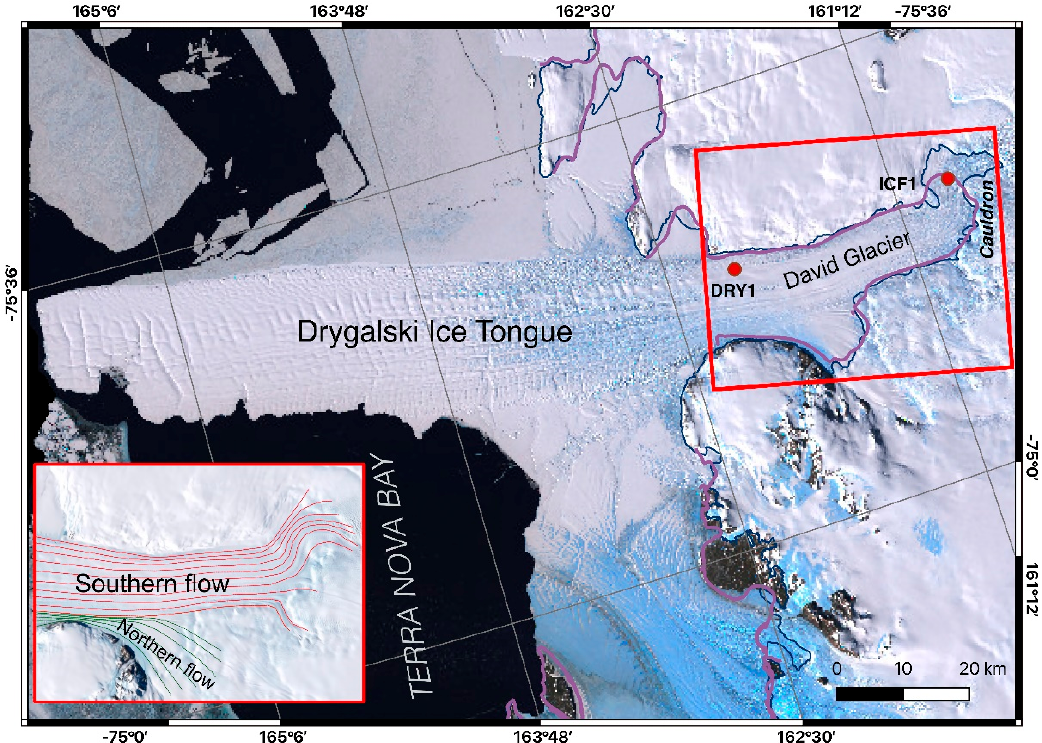
Figure 1. Terminal part of the David Glacier and the floating Drygalski Ice Tongue (USGS—LIMA Landsat high-resolution virtual mosaic). Red dots are the positions of the temporary GNSS stations ICF1 and DRY1. Two interpretations of the grounding line are reported in the figure: (blue) grounding line extracted from ASAID [4], (purple) grounding line described by the Project MEaSUREs Antarctic Grounding Line from Differential Satellite Radar Interferometry, Version 2. Both GNSS stations collected data simultaneously for 24 days in 2006, from January 15 to February 7. In the detail box inside the figure, the two main ice flows (southern and northern) are indicated with dashed red and green lines, respectively [6].